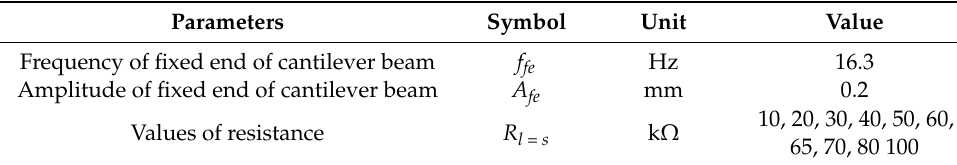
Table 5. Conditions of laboratory experiments.